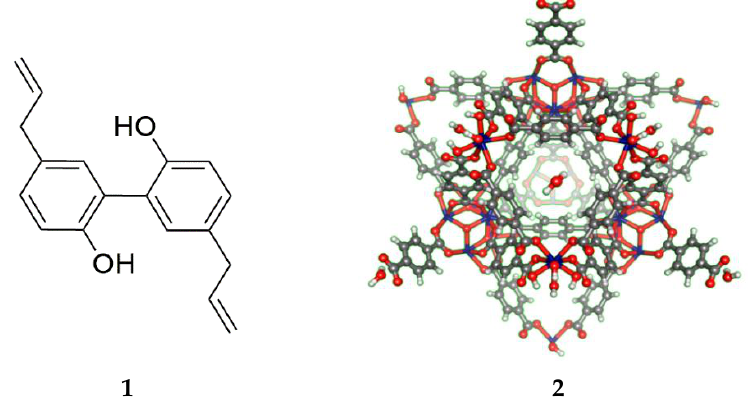
Figure 1. The structure of the ( 1 ) neolignan, magnolol (4-Allyl-2-(5-allyl-2-hydroxy-phenyl)phenol) and ( 2 ) Uio-66(Zr). (as visualized using ACD/Chemsketch ver 2018.1, Canada)